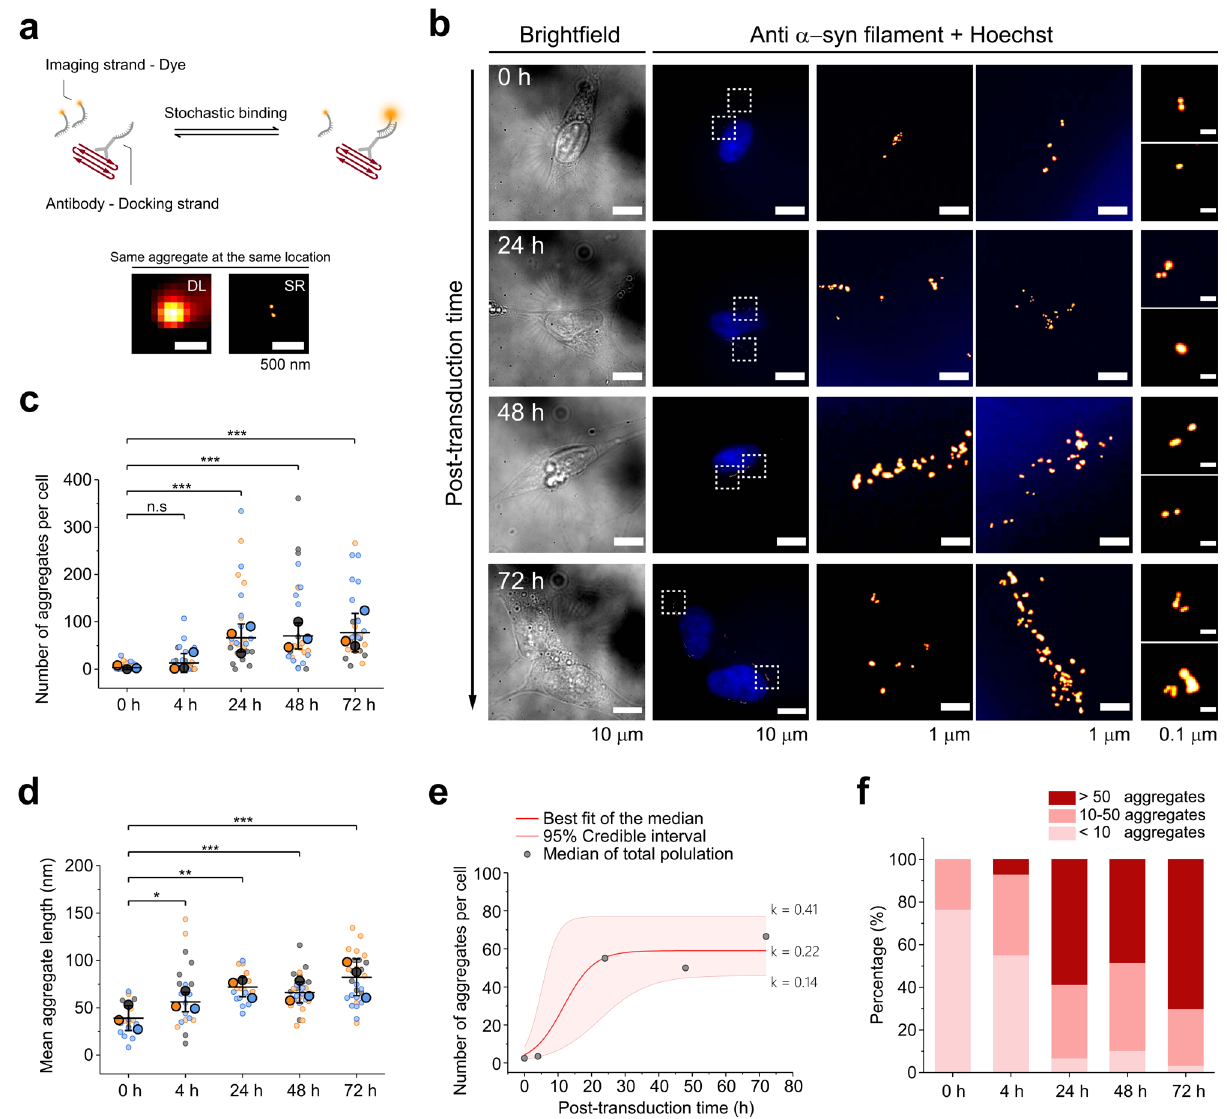
Fig. 1 Super-resolving the replication of intracellular α -syn aggregates inside cells. a Schematic of antibody-DNA-PAINT imaging. Cells at de fi ned time points were immunostained with MJFR-14-6-4-2 conjugated with the docking strand (DS). The complementary imaging strand (IS), linked to a fl uorescent Cy3b dye, interacts with the docking strand stochastically at a nanomolar concentration and hence can “ paint ” the boundary of the given object. The two microscopic images show that super-resolved (SR) images can distinguish two aggregated particles compared with conventional diffraction-limited (DL, thio fl avin T-stained) images. b Growth of intracellular α -syn aggregates over time. SH-SY5Y cells are incubated with a mixture of PFF seeds ( fi nal 2.5 µ M monomer equivalent of sonicated α -syn aggregates) and Bioporter for 4 h, then rinsed with PBS and cultured with fresh DMEM/10% FBS (time = 0 h after rinsing). Nuclei are stained blue with Hoechst dye; super-resolved α -syn aggregates are shown in red. c , d Intracellular aggregates increase in number and length after seed transduction. Statistical difference was determined by one-way ANOVA with Tukey ’ s multiple comparison test. N (total number of cells imaged) = 30, 29, 29, 29, 30 for 0, 4, 24, 48, 72 h, respectively. The cells were separately pooled for each biological replicate ( n = 3) and the median calculated for each pool; those three medians were then used to calculate the mean (horizontal bars), standard deviation (error bars), and p values. * p < 0.05, ** p < 0.01, *** p < 0.001, n.s. not signi fi cant; the difference of the means is not signi fi cant at the 0.05 level. e Kinetic analysis of the formation of intracellular aggregates; the median values from c are fi tted to a minimal model of replication (see “ Methods ” for details). The best fi t for the replication rate within cells is 0.22 h − 1 , with 95% credible interval CI between 0.14 and 0.41. f The percentage of cells containing >50 aggregates grows over time, while the percentage of cells containing <10 aggregates “ Methods ” for details). The time required for the number of cells of 0.01 – 10 s − 1 and 7 × 10 − 10 – 7 × 10 − 7 s − 1 (see “ Methods ” aggregates to double was calculated and used to extract rate constants for fi bril growth and fragmentation. The doubling time for α -syn aggregates in SH-SY5Y cells was ~5 h (95% credible interval = 2.4 – 7.1 h), with a replication rate of 0.22 h − 1 (95% CI = 0.14 – 0.41 h − 1 ). We used the doubling time to estimate the rates for fi bril growth and fragmentation rates in SH-SY5Y